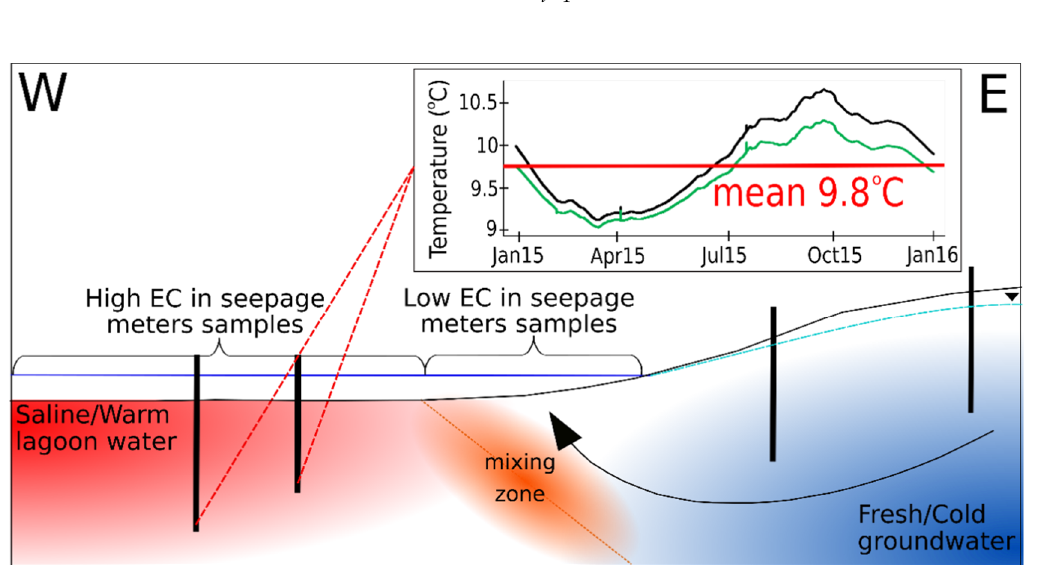
Figure 3. A schematic (not to scale) cross-section of the study area. In summer, fresh cold groundwater discharges into the lagoon from the east, creating a mixing zone when it encounters the saline slightly warmer lagoon water (a saline wedge is generated due to the density difference). The EC measurements east of the mixing zone showed lower EC values than the measurements west of the mixing zone. The mean annual temperature (9.8 °C) measured in two deep wells (4 m depth, black vertical lines, see Figure 1c) was used as a lower boundary condition for the BP method.